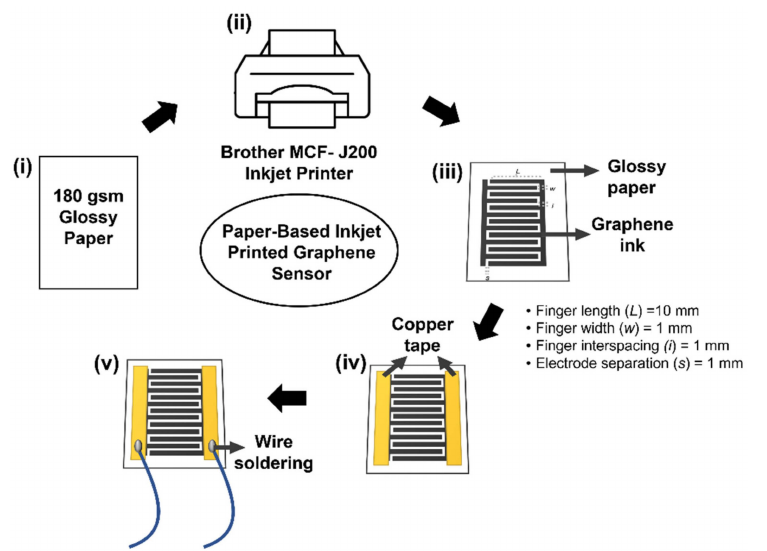
Figure 1. Schematic illustration of the fabrication of Inkjet-printed-paper sensor with graphene printing ink. ( i ) 180 gsm A4 glossy inkjet paper, ( ii ) IDE pattern printed using a Brother MFC-J200 inkjet printer, ( iii ) graphene-printed paper sensor and sensor geometrical dimension, ( iv ) copper tape was pasted on both sides of the paper sensor, and ( v ) soldered wires on the copper